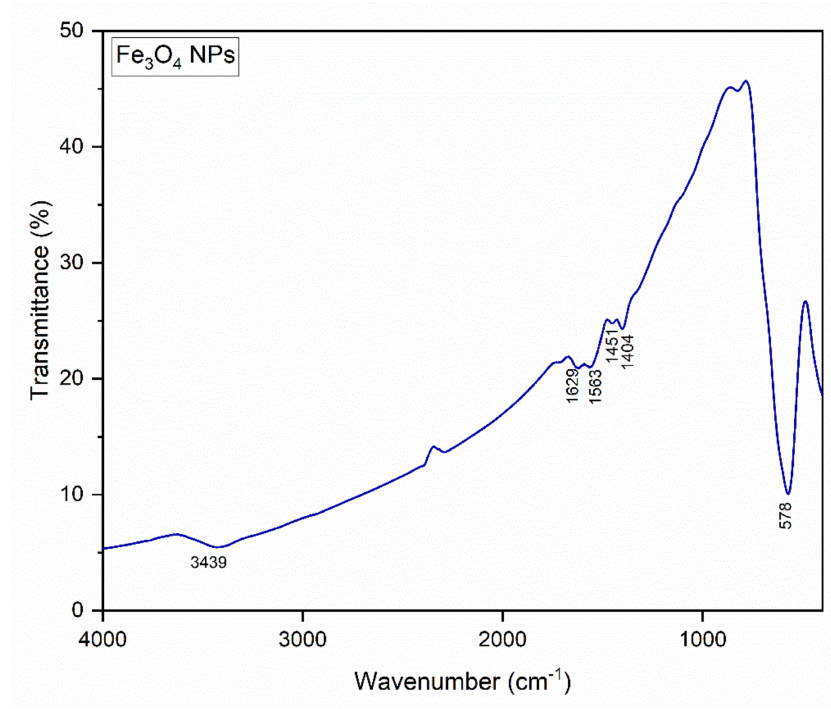
Figure 7. FT-IR spectra of the Fe 3 O 4 -PAA